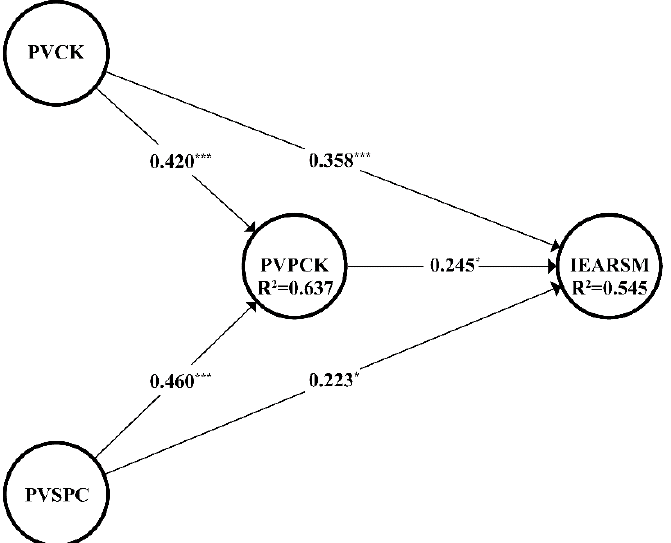
Figure 2. The structural model with main results. Notes. * p < 0.05, *** p < 0.001. PVCK = perceived value of content knowledge, PVPCK = perceived value of pedagogical content knowledge, PVSPC = perceived value of students’ participation in the classroom, IEARSM = intentions toward engagement with academic reading on social media.